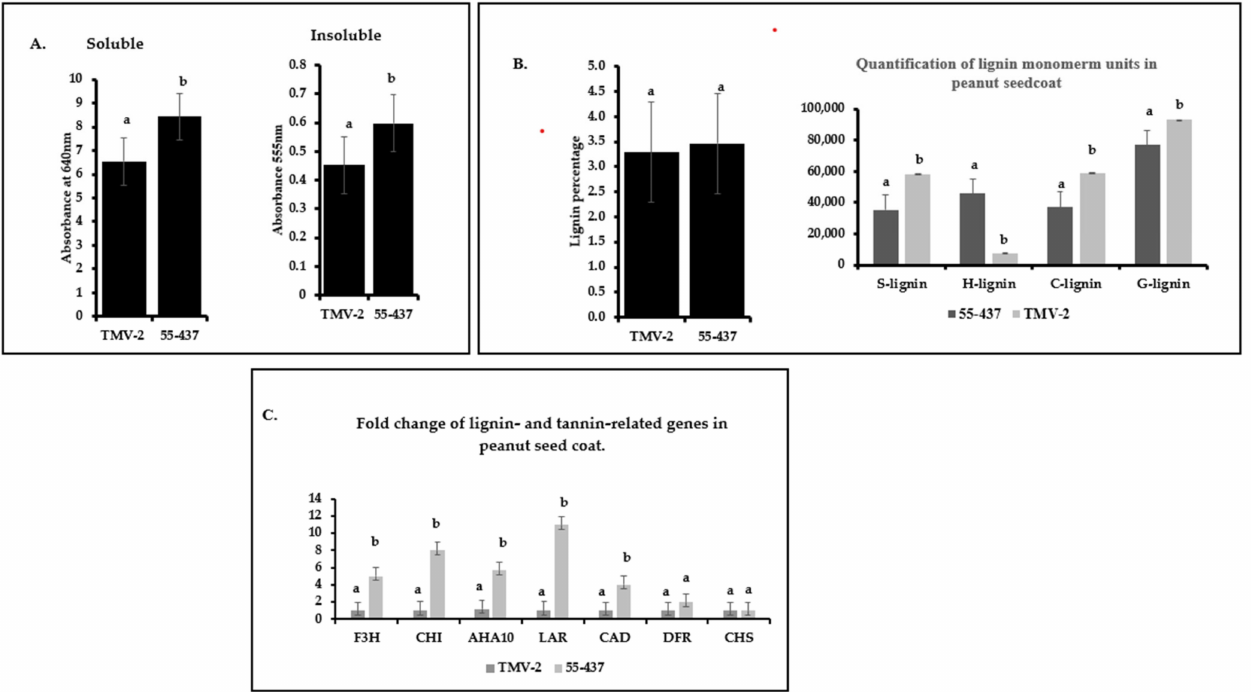
Figure 6. Quantification of insoluble and soluble proanthocyanidin in peanut seed coat. ( A ) Seed coats from greenhouse grown peanut varieties 55-437 and TMV-2 was used for biochemical analysis of soluble and insoluble proanthocyanidins. The error bar represents the standard error. The data are an average of three technical replicates and three biological replicates. One-way ANOVA was used to determine the significant difference between different groups. Means not sharing the same letter are significantly different ( p < 0.05). ( B ) Cell-wall lignin was extracted from the collected tissue and was measured using the spectrophotometer. Lignin monomer units were estimated using GC-MS. The data are an average of three technical replicates and three biological replicates. One-way ANOVA determined the statistically significant difference between different groups. Means not sharing the same letter are significantly different ( p < 0.05), and the error bar represents the standard error. ( C ) Peanut varieties 55-437 and TMV-2 were grown in the green house, and seed coat tissue was harvested 67 days after planting. The seed coat was used for RNA extraction and qPCR analysis. Statistically significant difference between different groups was determined by one-way ANOVA. Means not sharing the same letter are significantly different ( p <